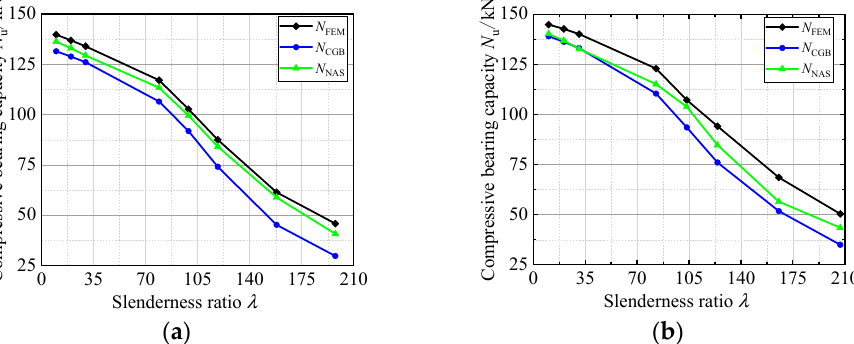
Figure 21. Comparisons of the bearing capacities between numerical analyses and standards ( a ) C90- 40-15-1.5-L; ( b )